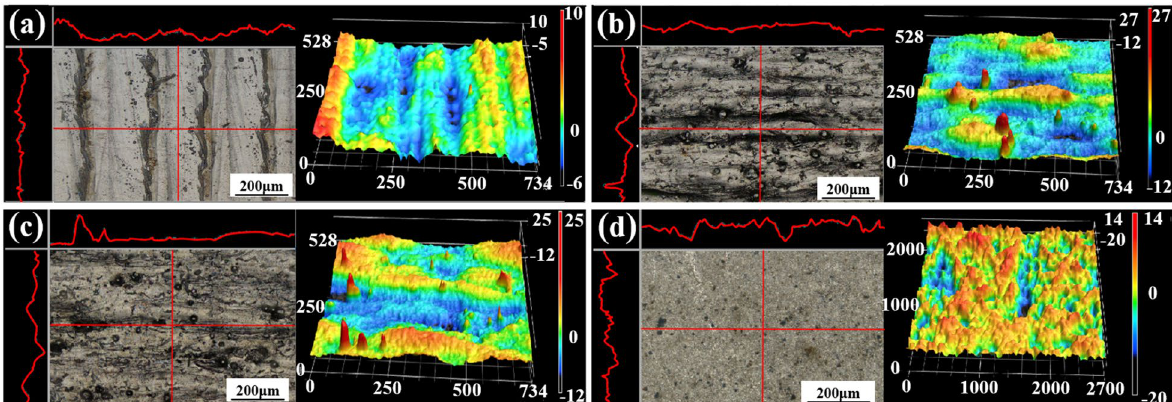
Figure 7 a – c Surface morphology and 3D display of the XY , YZ and ZX surface of the SLMed sample; d Surface morphology and 3D display of the as-cast sample